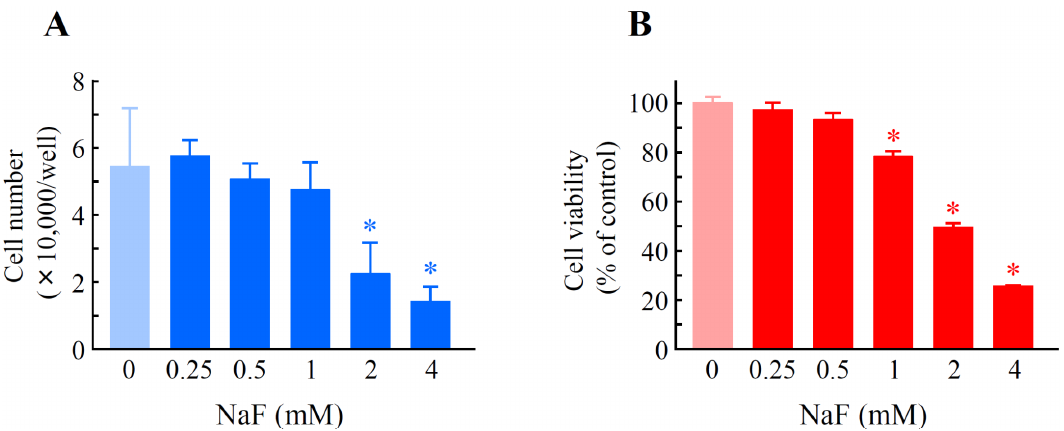
Figure 1. Effects of sodium fluoride (NaF) on cell number and cell viability in rat oral epithelial ROE2 cells. Cells were incubated with NaF at concentrations of 0 to 4 mM for 24 h. ( A ) Cell number was counted using a hematocytometer. The data represent the means ± standard deviations ( N = 4); and ( B ) Cell viability was monitored using a WST-8 assay. Cells treated with 0 mM NaF served as a control (100%). The data represent the means ± standard deviations ( N = 8). * p < 0.05 vs. NaF (0 mM) (Student’s t